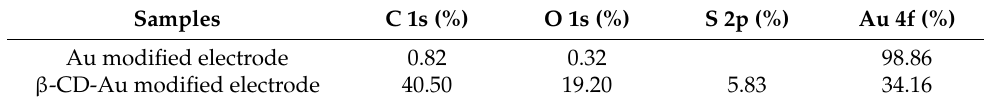
Table 1. Elemental analysis on the surface of Au modified electrode and β -CD-Au modified electrode.